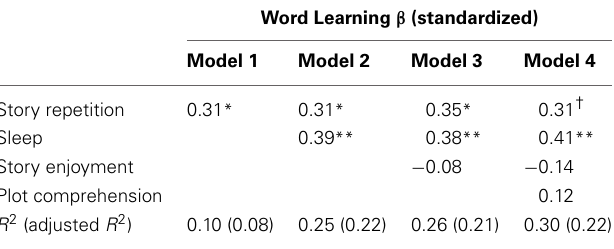
Table 6 | A series of regression models predicting children’s word retention 7 days after story exposure based on story repetition, sleep, story enjoyment and plot